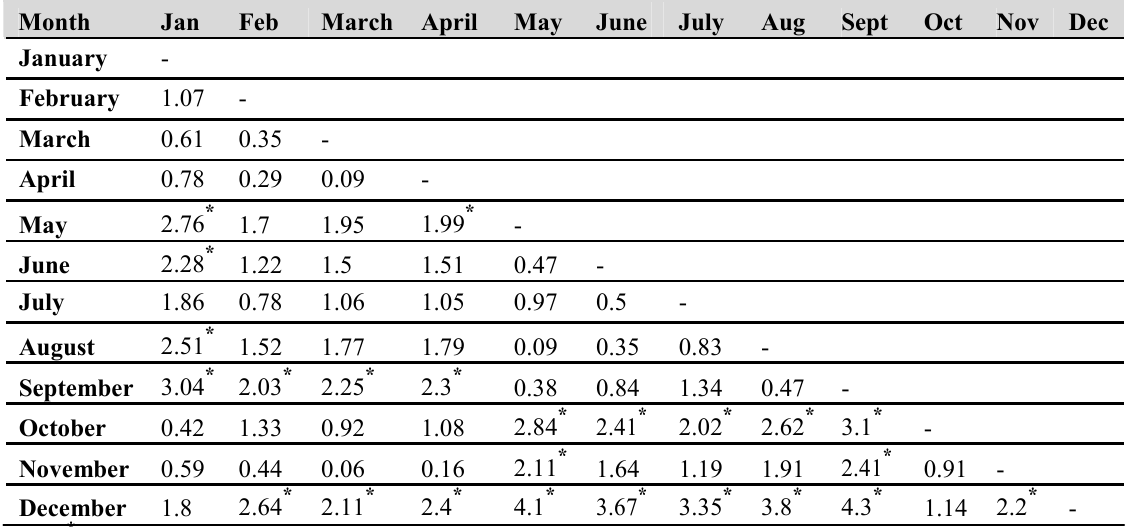
Table 2. Comparative analysis of the mean monthly visits of patients with schizophrenia in the emergency department of the regional dispenser for mental disorders in Sofia,